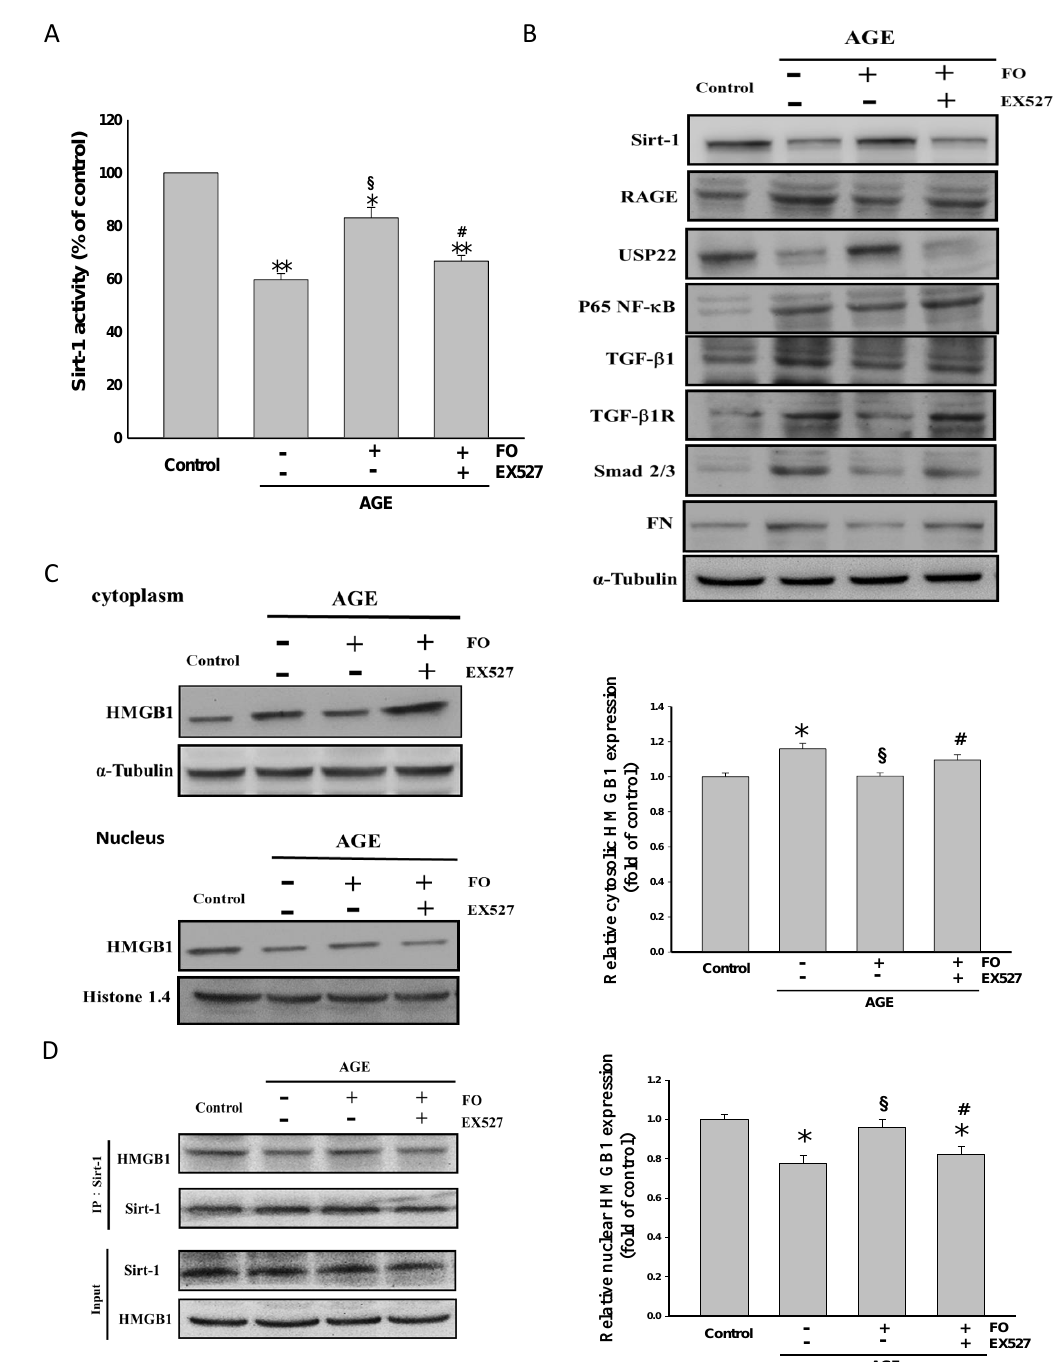
Figure 1. The e ff ects of fucoidan on Sirt-1 activity, anti-high mobility group box 1 (HMGB1) cellular Figure 1 location, and fibrosis-related signaling pathways. The rat renal proximal tubular epithelial cells (NRK-52E) cells were incubated with advanced glycation product (AGE) (100 µ g / mL) for 24 h followed by treatment with fucoidan (100 µ g / mL) for 24 h in the presence or absence of EX527 (200 nM). The Sirt-1 activity ( A ), the expression of fibrosis-related genes ( B ), the cytosolic and nuclear levels of HMGB1 ( C ), and the association of Sirt-1 with HMGB1 in the nucleus ( D ) were determined in various groups. FO: fucoidan. Results were expressed as the mean ± SEM ( n = 5). * p < 0.05, ** p < 0.01 vs. control group (untreated NRK-52E cells); § p < 0.05 vs. AGE-treated alone cells; # p < 0.05 vs. AGE and fucoidan-treated